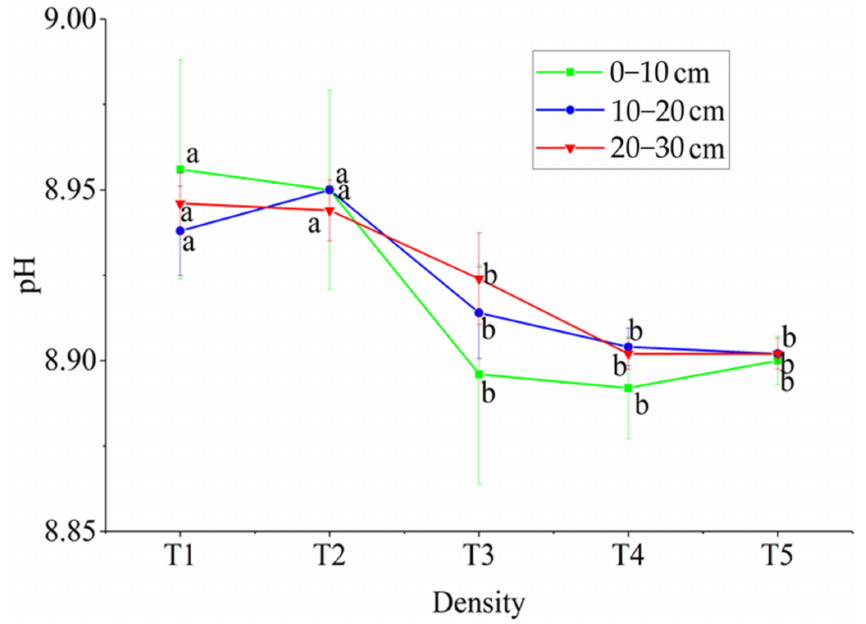
Figure 5. Soil pH in the 0–10, 10–20, and 20–30 cm soil layers under the five population densities. The different letters for each line denote the significant differences ( p < 0.05) among the five densities.